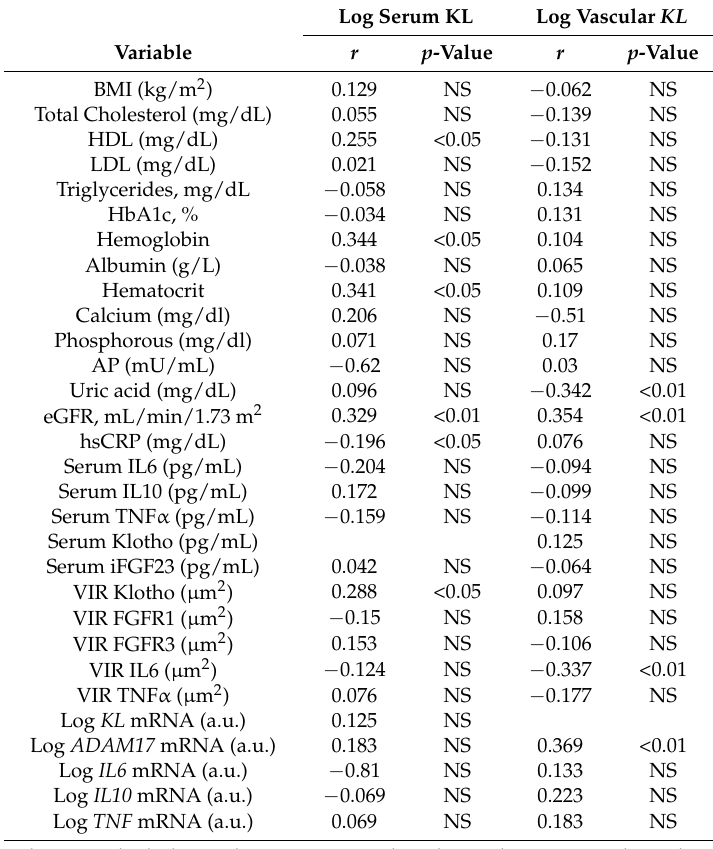
Table 2. Correlations of serum and vascular gene expression levels of Klotho in diabetic patients.